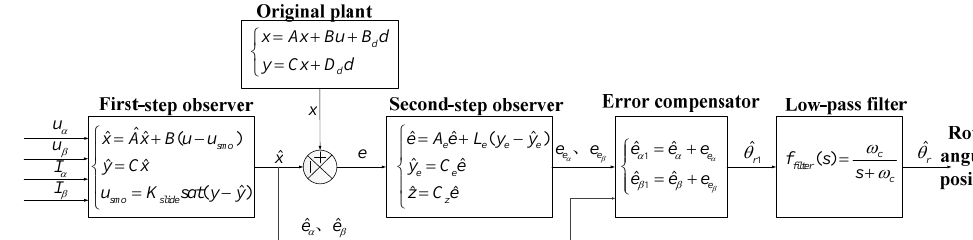
Figure 4. Two ‐ step angular position estimation and compensation. Figure 4. Two-step angular position estimation and compensation.